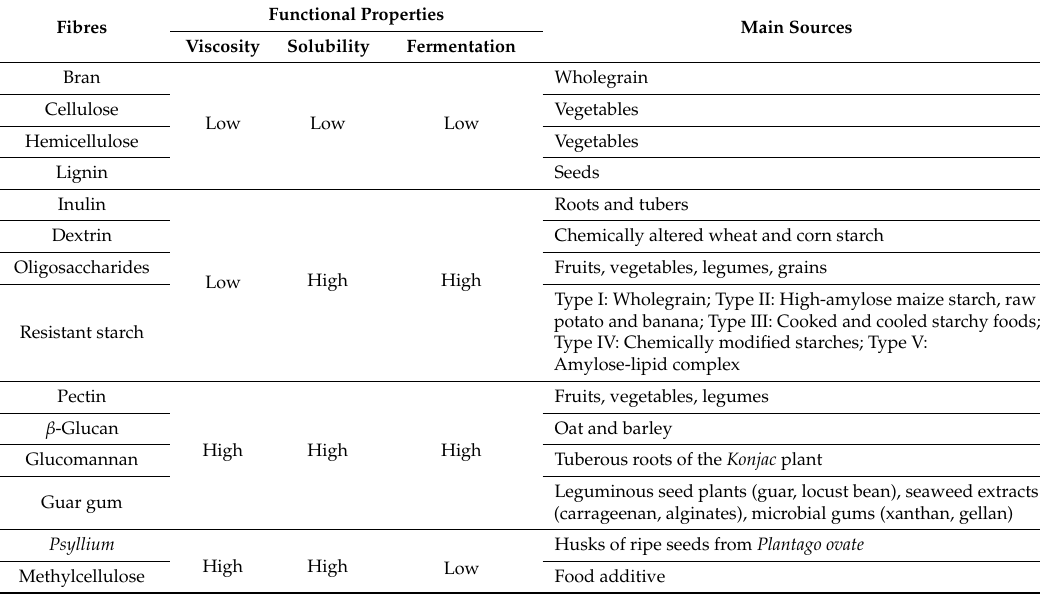
Table 1. Functional properties and main sources of dietary fibres, according to McRorie et al.